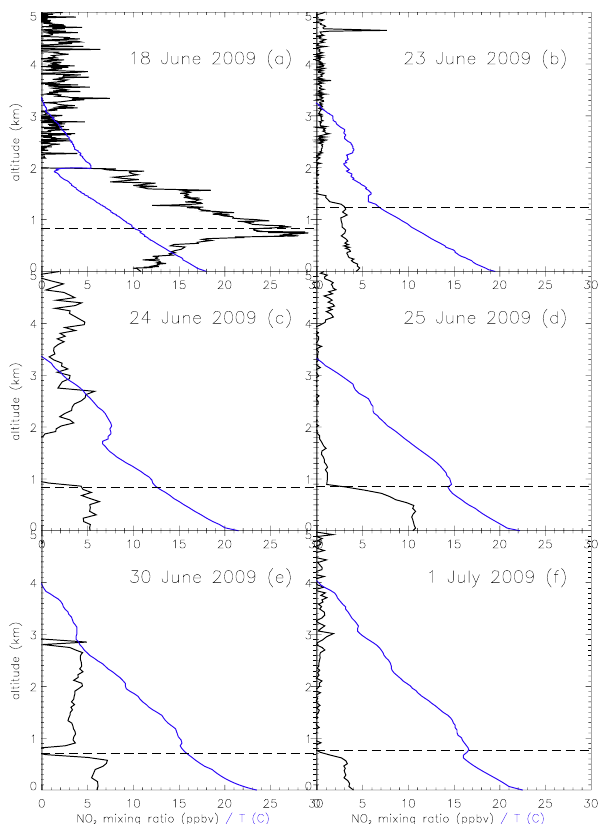
Fig. 11. Six vertical NO 2 profiles measured during CINDI June/July 2009. On the x-axis the NO 2 volume mixing ratio and on the y-axis the altitude (km). The dashed horizontal lines indicate the boundary layer height above Cabauw around 10:30UT, mea- sured by the KNMI Ceilometer. The blue lines indicate the outside air temperature during the sonde